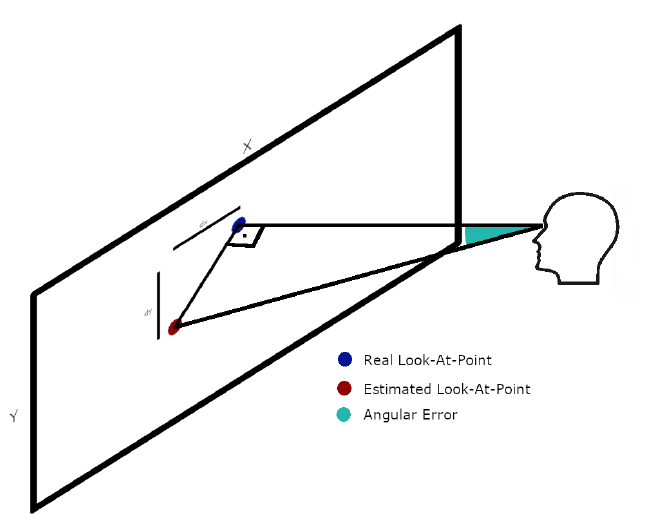
Figure 6. Angular error resulting from gaze-estimation. The angular error corresponds with the angle between the vectors Eyes Position—Real look-at-point and Eyes Position—Estimated